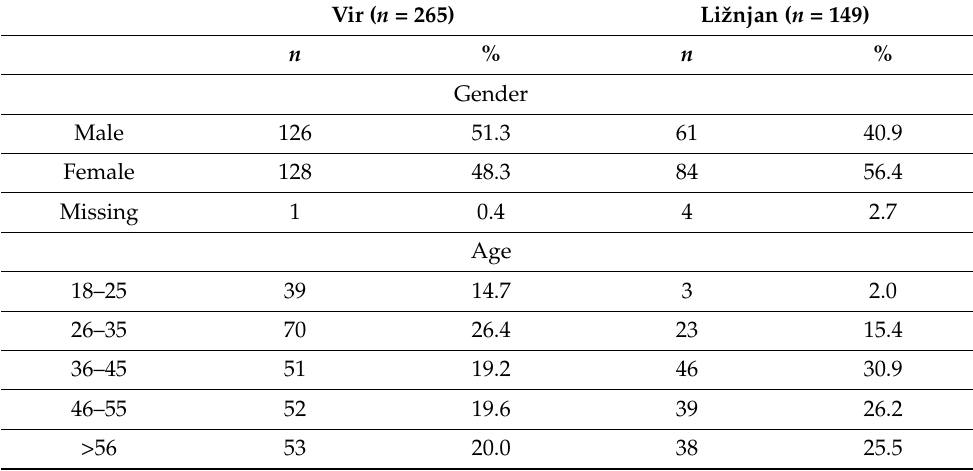
Table 2. Demographic profile of